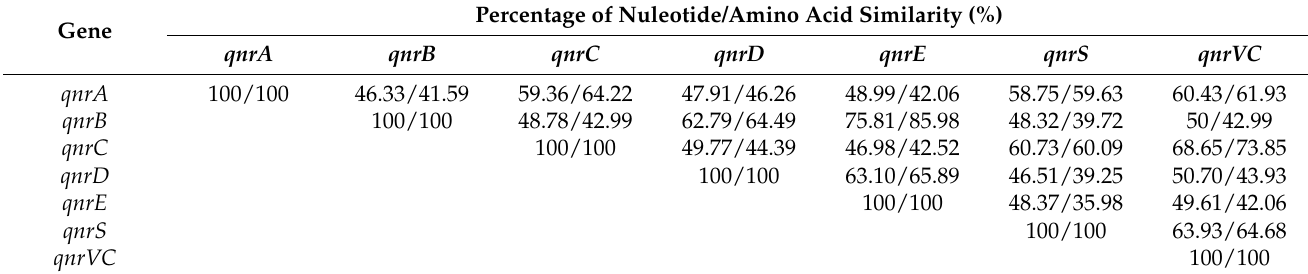
Table 2. Percentages of the similarity of nucleotide and amino acid sequences of the qnr